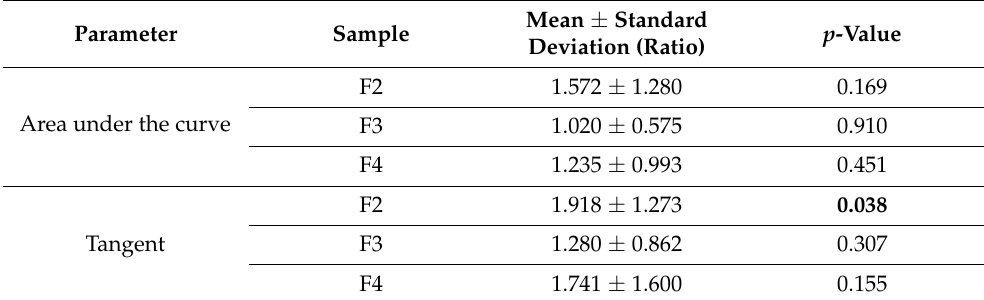
Table 3. The ratio between the values obtained at each sample site and the control values for the parameters of the area under curve and slope of the tangent line in the